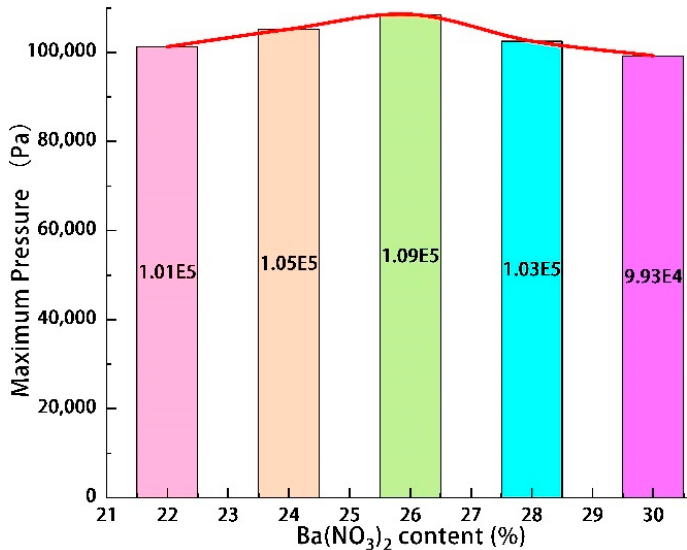
Figure 6. Effect of Ba(NO 3 ) 2 content on maximum pressure.